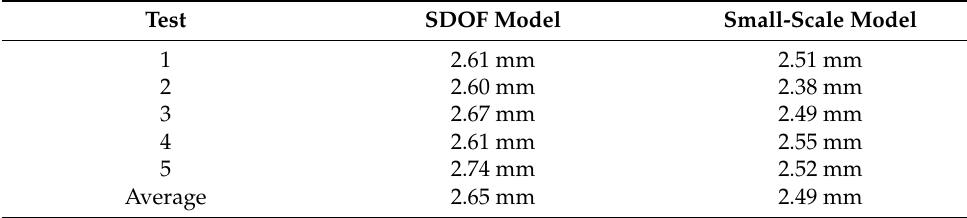
Figure 14. Time history curve of the small-scale model by scaled El Centro earthquake vibration test: ( a ) first test; ( b ) second test; ( c ) third test; ( d ) fourth test; ( e ) five test; ( f ) overlapping entire tests. From the scaled El Centro earthquake vibration tests, the maximum displacements of the SDOF and small-scale models were obtained (Table 7). Table 7. Maximum displacement.